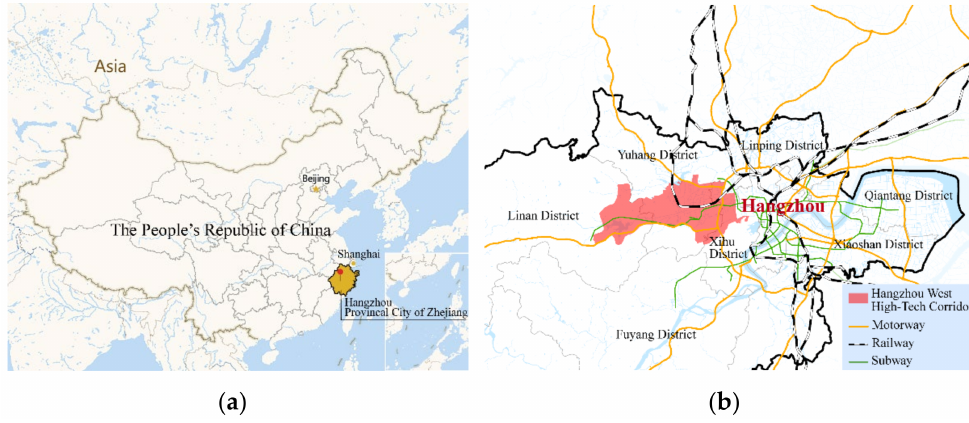
Figure 1. Location of Hangzhou West High-Tech Corridor: ( a ) Hangzhou, China; ( b ) location and external transportation of the Corridor.